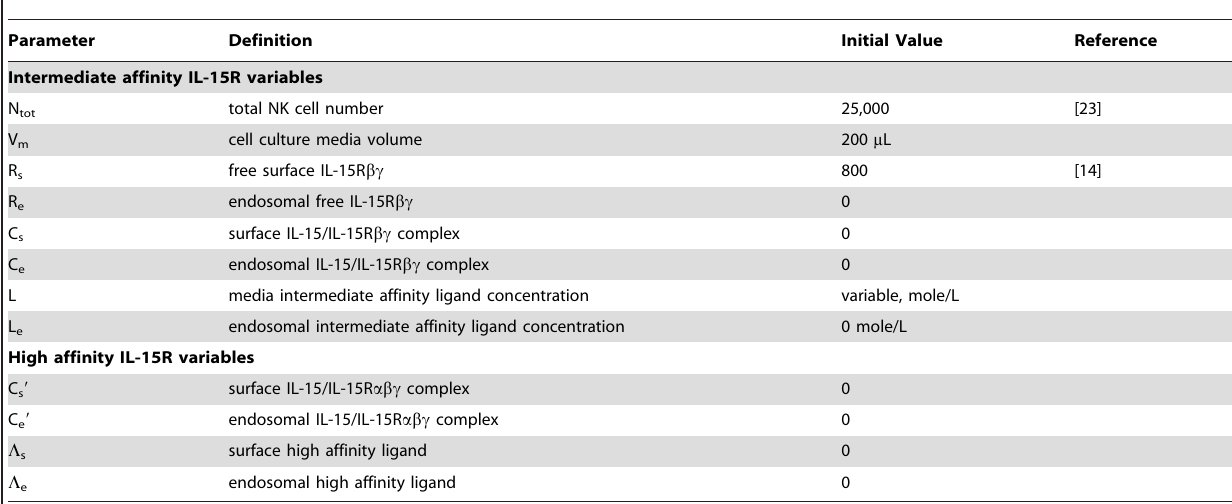
Table 1. Differential equation variables and initial